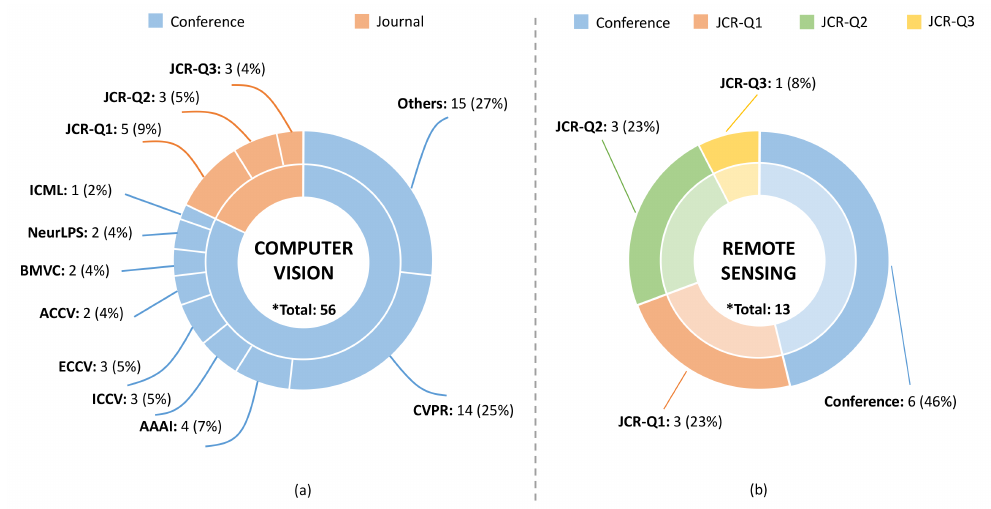
Figure 3. Publication sources of literature in the field of remote sensing image interpretation ( a ) and computer vision ( b ). The statistical result covers some journals and conferences. Journal Citation Reports (JCR) above is a partitioning method for journals retrieved by the Science Citation Index (SCI), which updates yearly and divides journals into four categories, from Q1 to